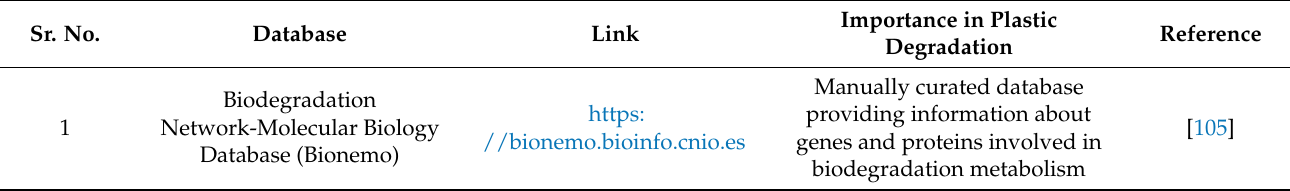
Table 2. List of biodegradation databases and pathway prediction systems. Sr.